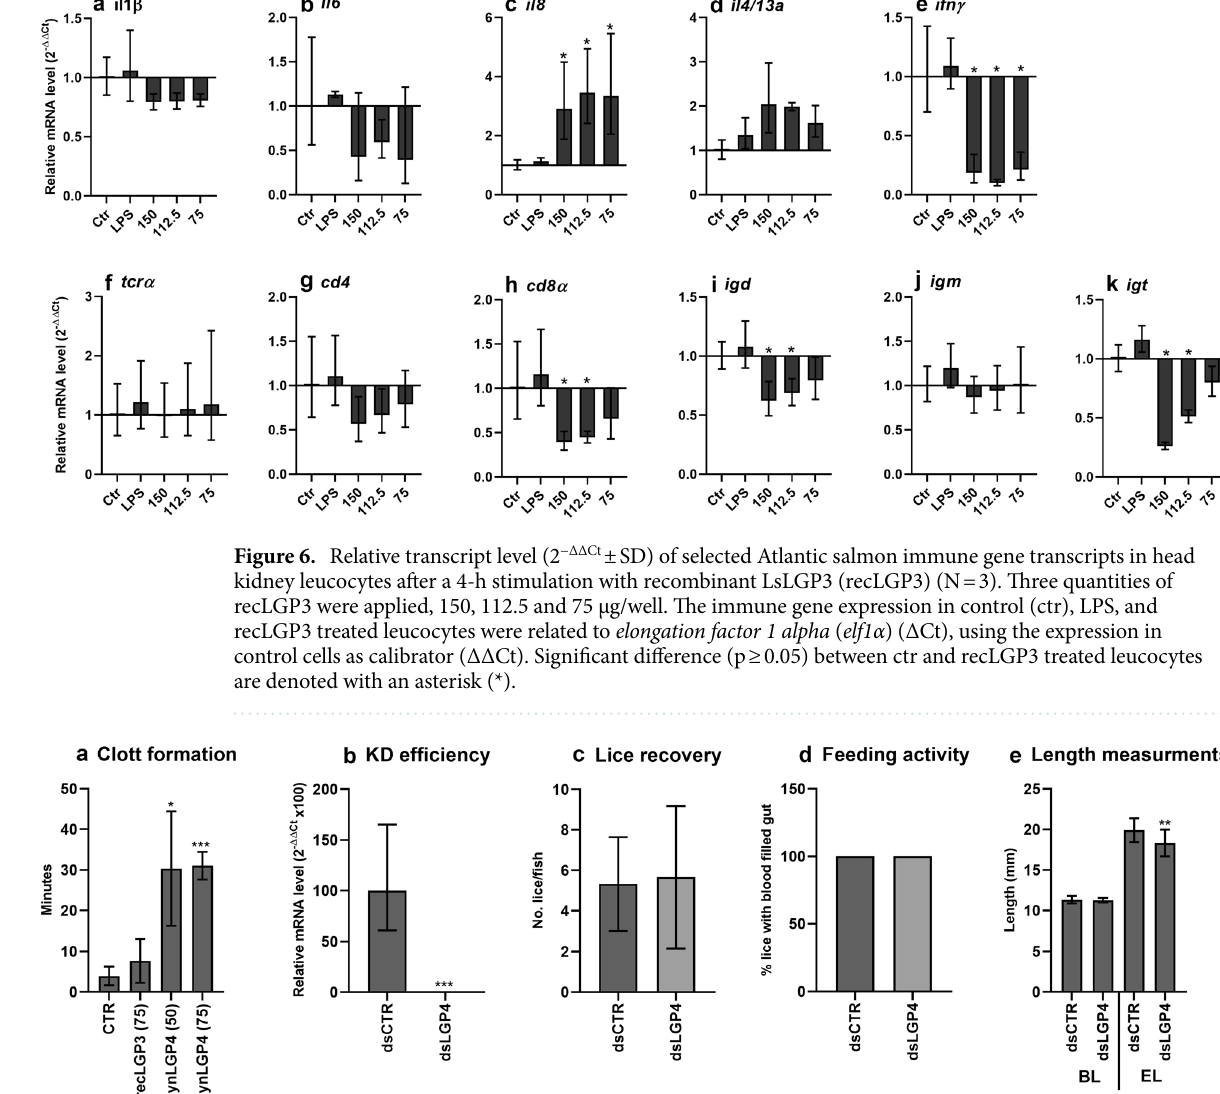
Figure 7. Analysis of LsLGP3 and 4’s role in blood coagulation. ( a ) Coagulation efficiency in control (CTR), recLGP3 (75 μg) and synLGP4 (50 and 75 μg) treated plasma measured as time to plasma gel formation after thromboplastin addition (minutes ± SD; N = 3). Some synLGP4 treated samples did not coagulate during the experiment and was set to 45 min. ( b–e ) Knock down (KD) study of LsLGP4 during the mobile salmon louse stages to analyse the importance of LsLGP4 in blood feeding. ( b ) Relative transcript level (2 −∆∆Ct ± SD) of LsLGP4 in control (dsCTR) and dsLGP4 treated lice at 32 dpi, related to the LsEF1α and LsADT3 reference genes (N = 5). ( c ) Average number of recovered lice per fish (± SD) in fish (N = 3) infested with 10 control or dsLGP4 treated lice/fish. ( d ) Percentage of lice with visible blood in intestine at sampling in control and dsLGP4 treated lice (dsCTR N = 16, dsLGP4 N = 18). ( e ) The body length (BL) and egg string length (EL) of control and dsLGP4 treated lice (mm ± SD, dsCTR N = 16, dsLGP4 N = 18). Significant difference between control and treatment group are denoted with one asterisk (*) if p ≥ 0.05, two asterisk if p ≥ 0.01 and three asterisk if p ≥